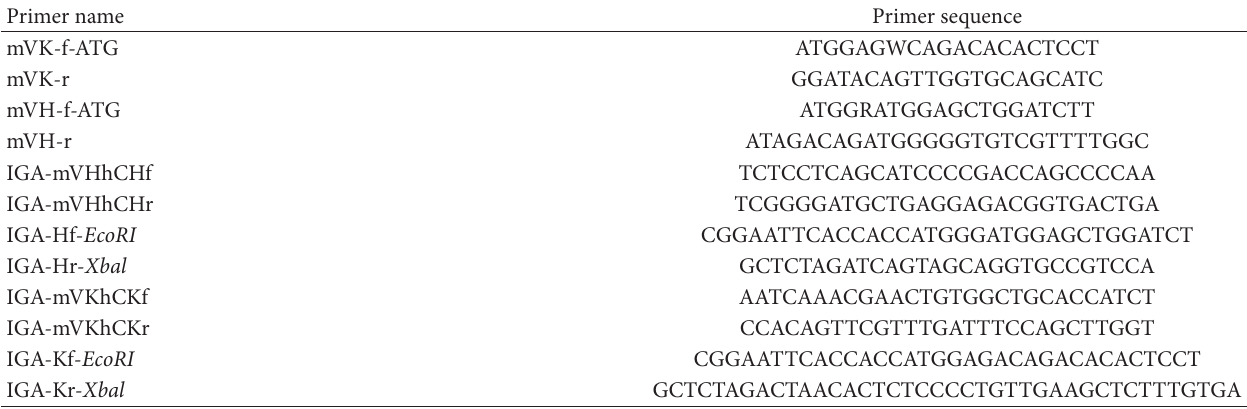
Table 1: Primers used in this